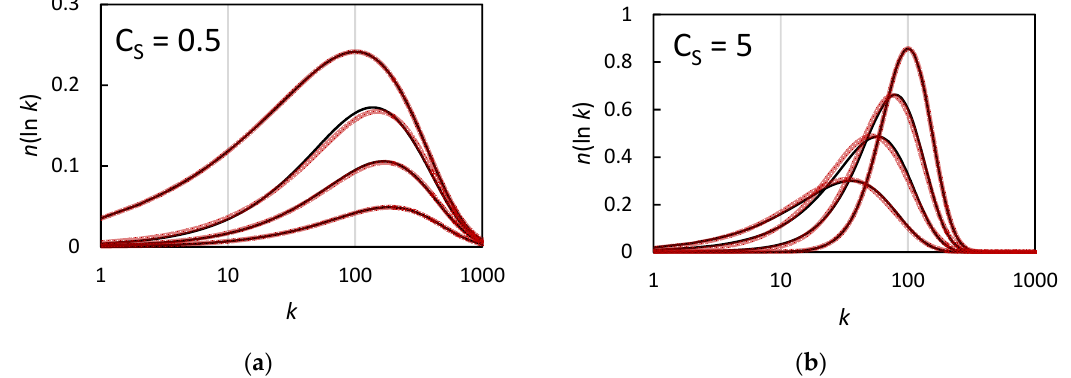
Figure 2. Comparison of negative binomial approximation (thick red lines) with calculated CLDs (thin black lines) for polymerizations with T = 100, C S = 0.5 ( a ) or 5 ( b ), conversion = 0.25, 0.5, 0.75 and 1.